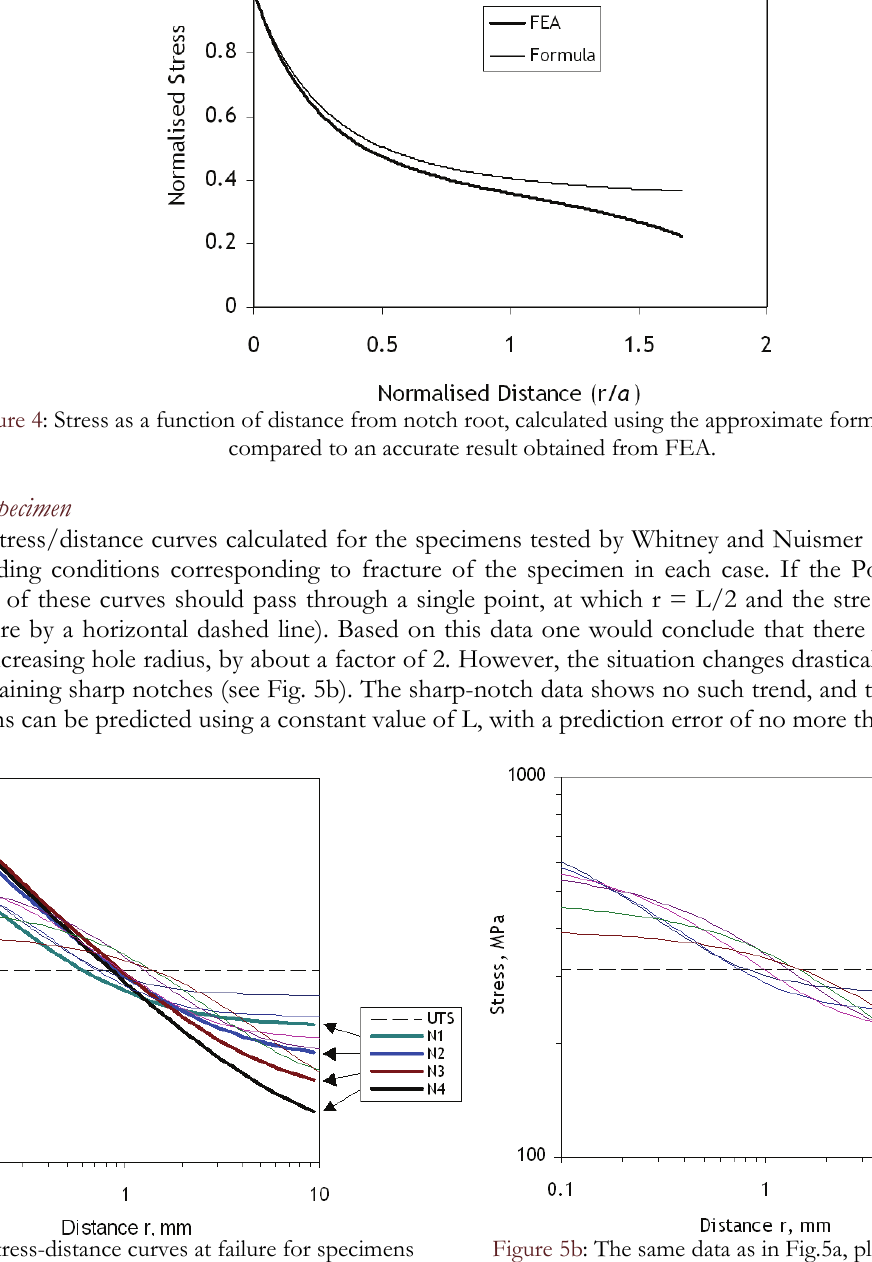
Figure 5b: The same data as in Fig.5a, plus lines representing the stresses in sharply-notched specimens of the same material. The symbols N1-N4 represent increasing notch